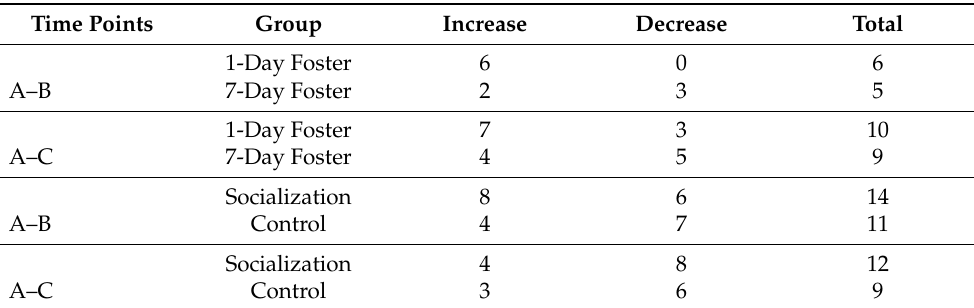
Table 1. Number of cats in each foster group and each in-shelter group that had an increase or decrease in UCCR from time point A to B and A to C.